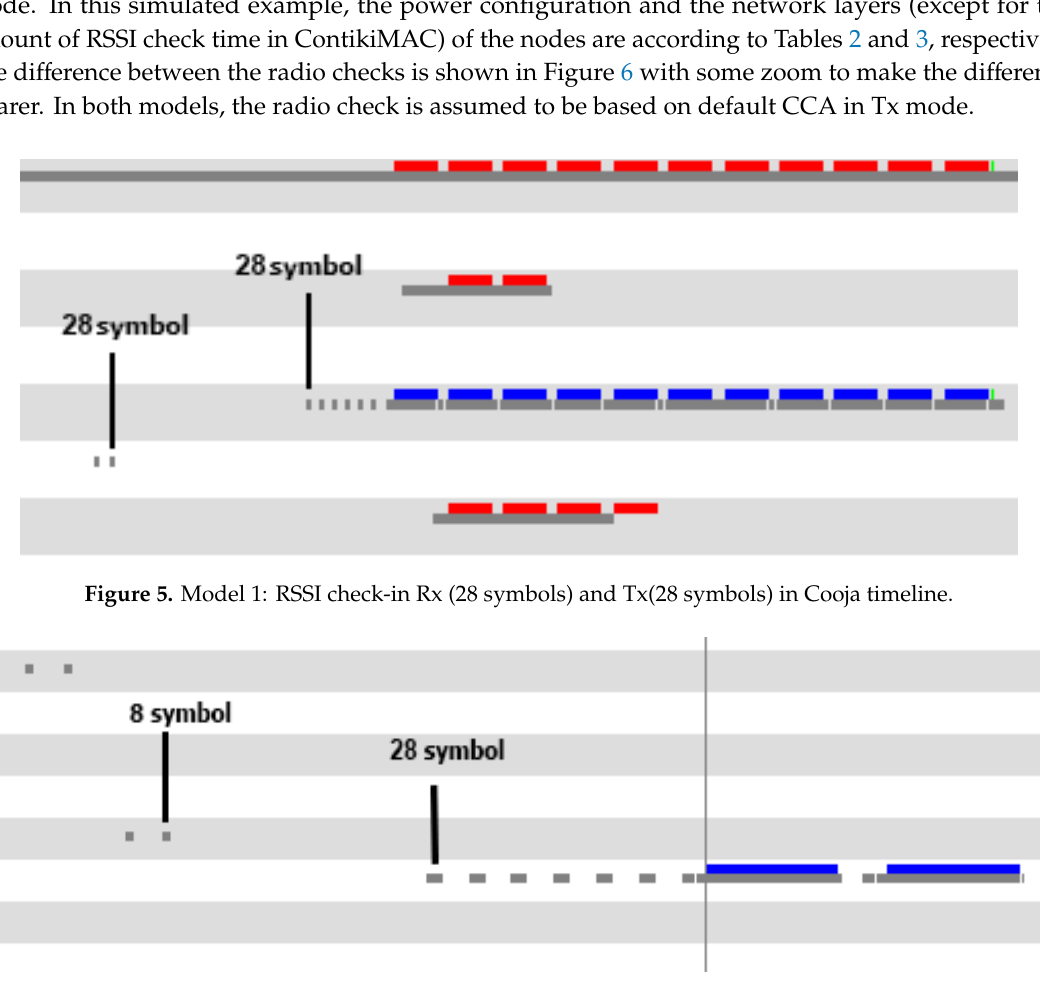
Figure 6. Model 2: RSSI check-in Rx (8 symbols) and Tx (28 symbols) in Cooja Timeline.